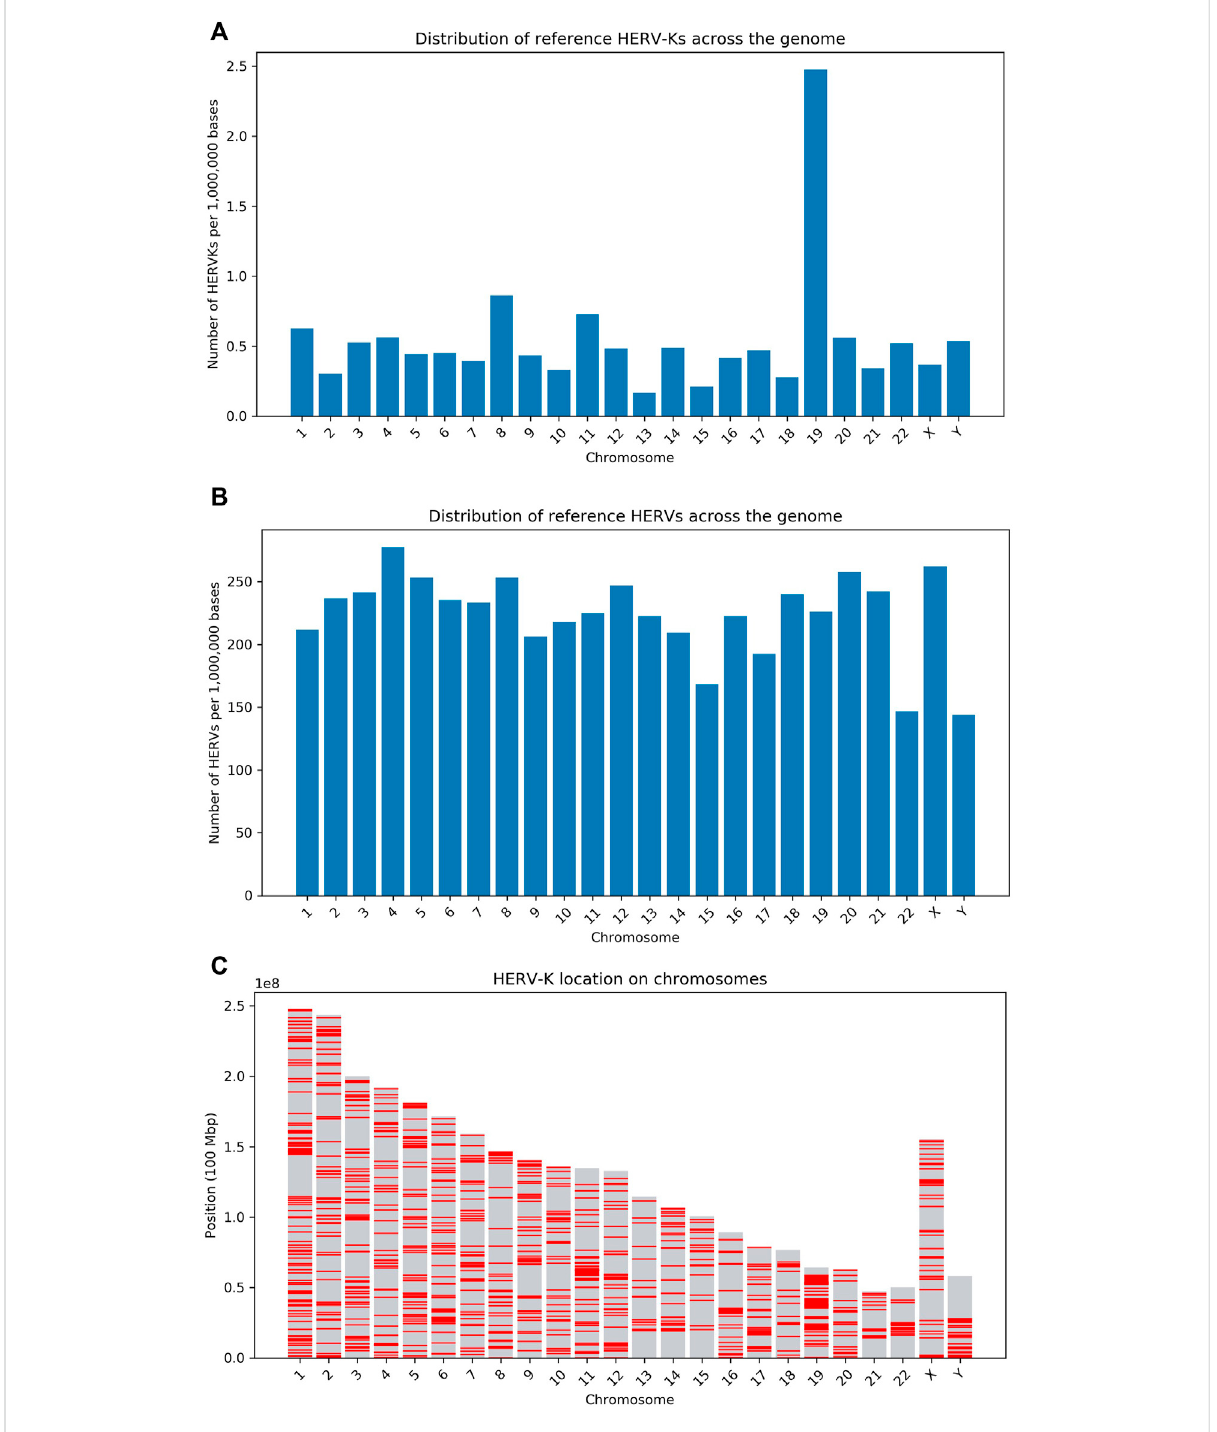
FIGURE 3 OverviewofthedensityofHERVlociinthehumangenome. (A) NumberofHERV-Kspermillionbasesineachhumanchromosome(asgivenby the UCSC RMSK table). The high HERV density in chr19 has been previously reported (Katzourakis et al., 2007) and other transposable elements are also enriched on this chromosome (Gianfrancesco et al., 2019). (B) Number of HERVs and LTR sequences per million bases in each human chromosome – Data is from the UCSC RMSK table. (C) This panel shows the distribution of HERV-K on each chromosome, with a red line indicating the presence of the HERV-K LTR. These results are obtained from the LTR5/HERV-K UCSC RMSK